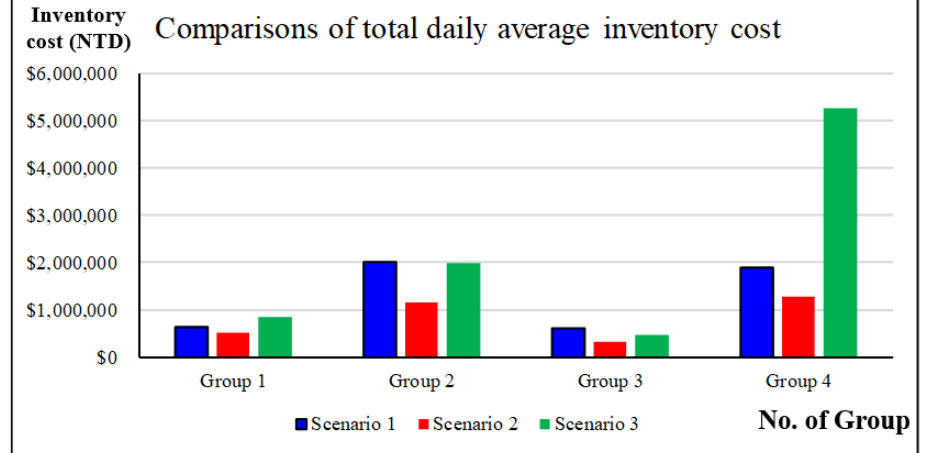
Figure 16. Comparison of simulation results of four drug groups for three scenarios.